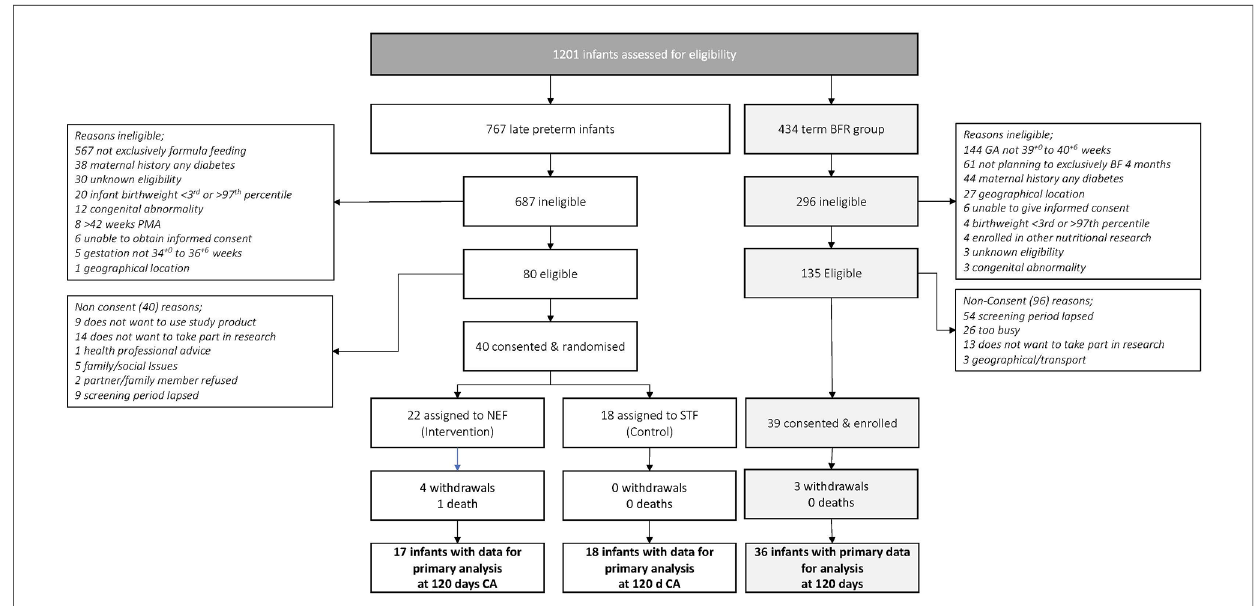
FIGURE 1 Flow of late preterm infants and term breastfeeding infants throughout the study. BFR, breastfeeding reference group; CA, corrected age; GA, gestational age; NEF, nutrient enriched formula group; STF, Standard Term Formula